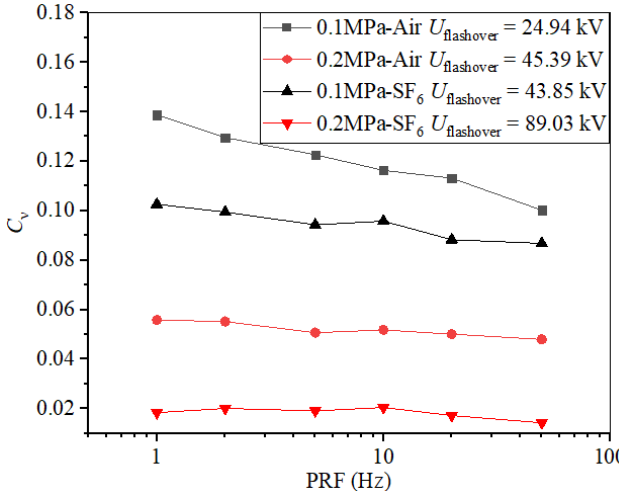
Figure 9. Dispersion of flashover voltage in SF 6 and